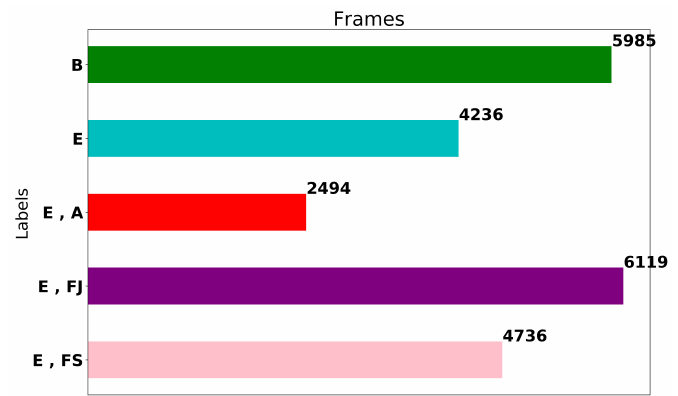
Figure 2. Label distribution of a total 23,570 frames of the complete